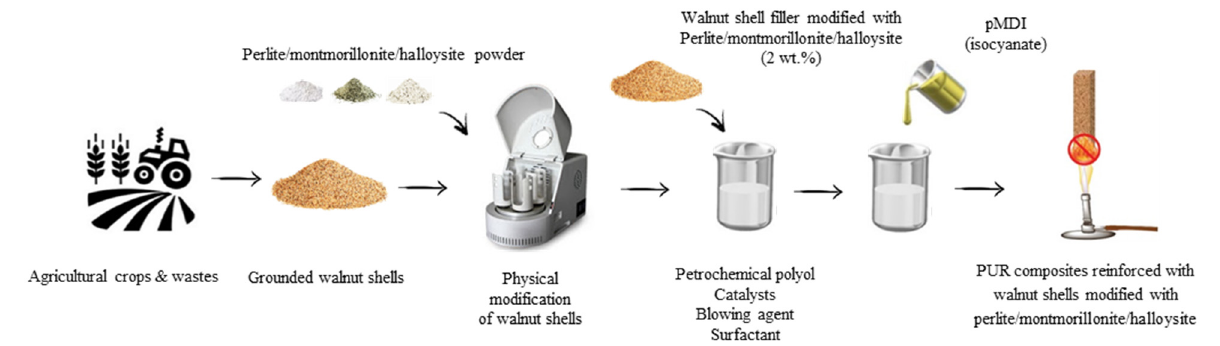
Figure 13. Schematic procedure of the synthesis of PUR composites reinforced with walnut shells modified with perlite/montmorillonite/halloysite.